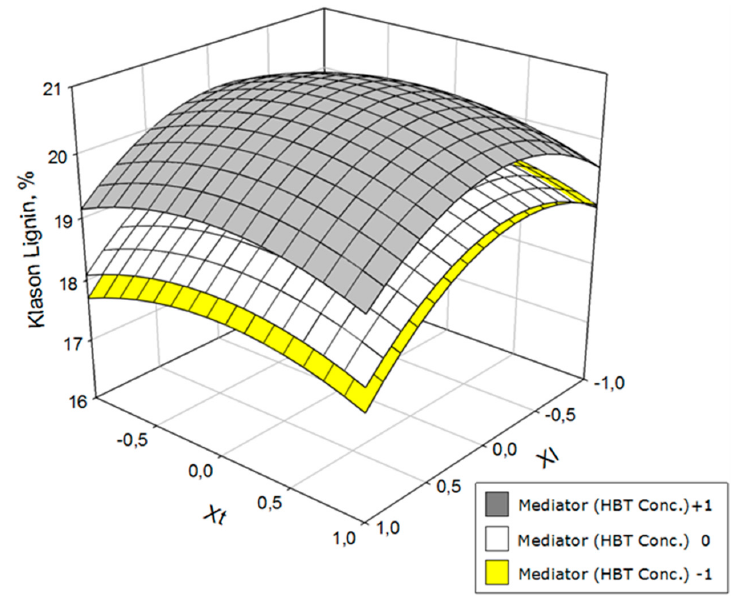
Figure 3. Variation of the klason lignin as a function of laccase concentration ( X l ) and operation time ( X t ) at three HBT concentration levels.